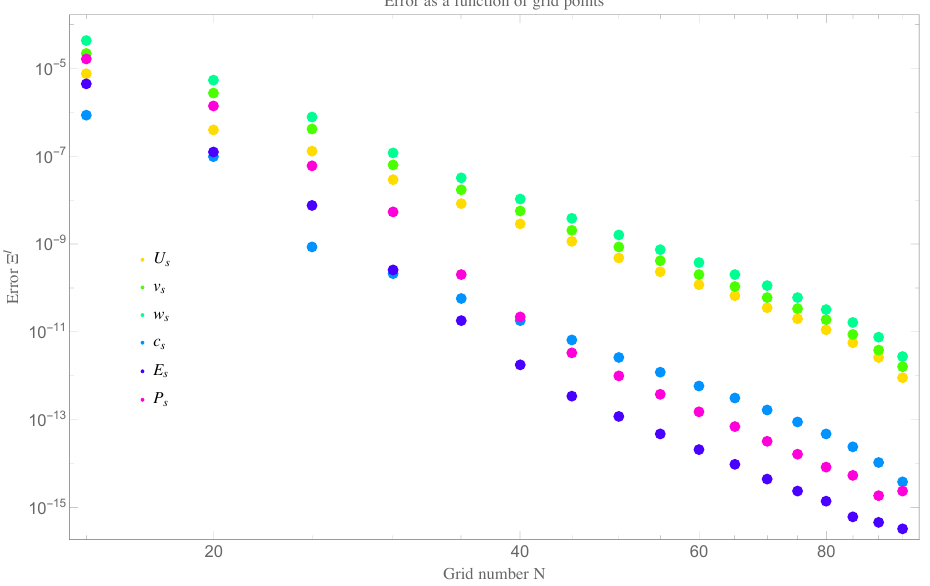
Figure 26 . We display an example of the grid point convergence of the solutions for the spacetime metric functions, Ξ I , as defined in eq. (B.17). The solutions we display are computed at example values of µ/T = 0 . 32772 and B/T 2 = 10 . 740155 with γ = 2 /